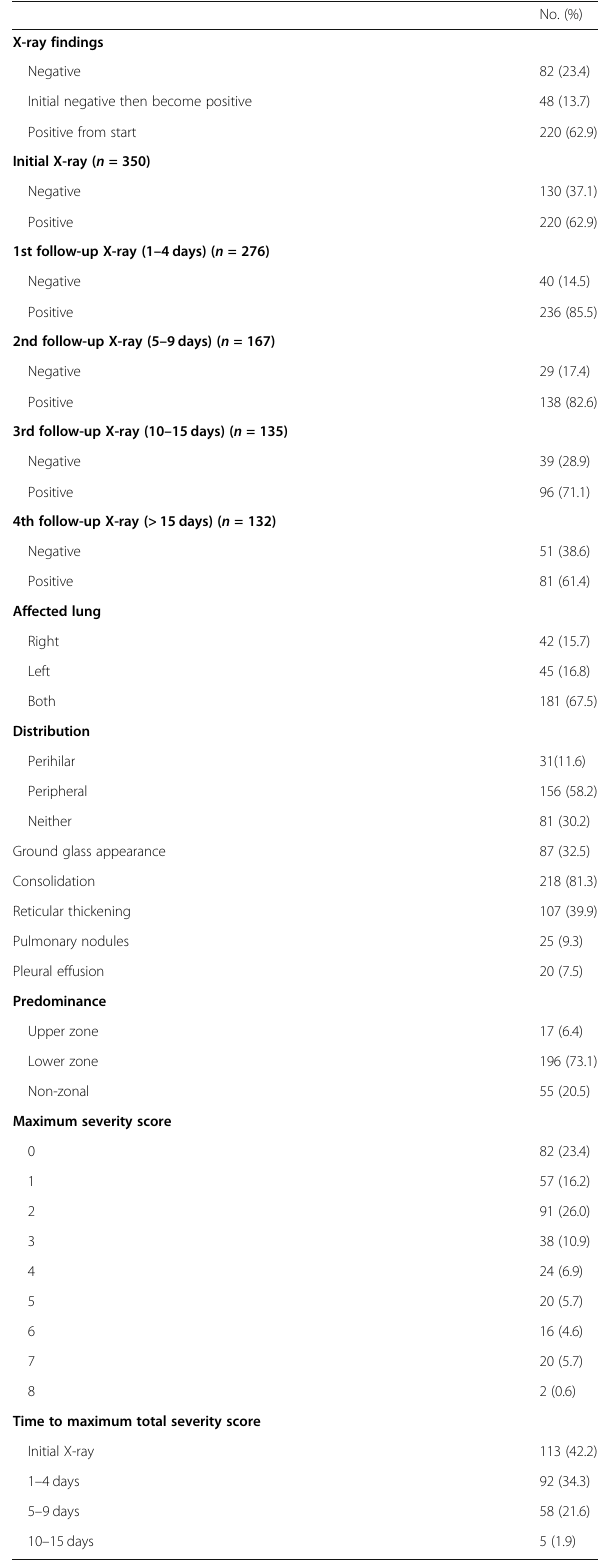
Table 1 Demographic presentations of the patients Variable